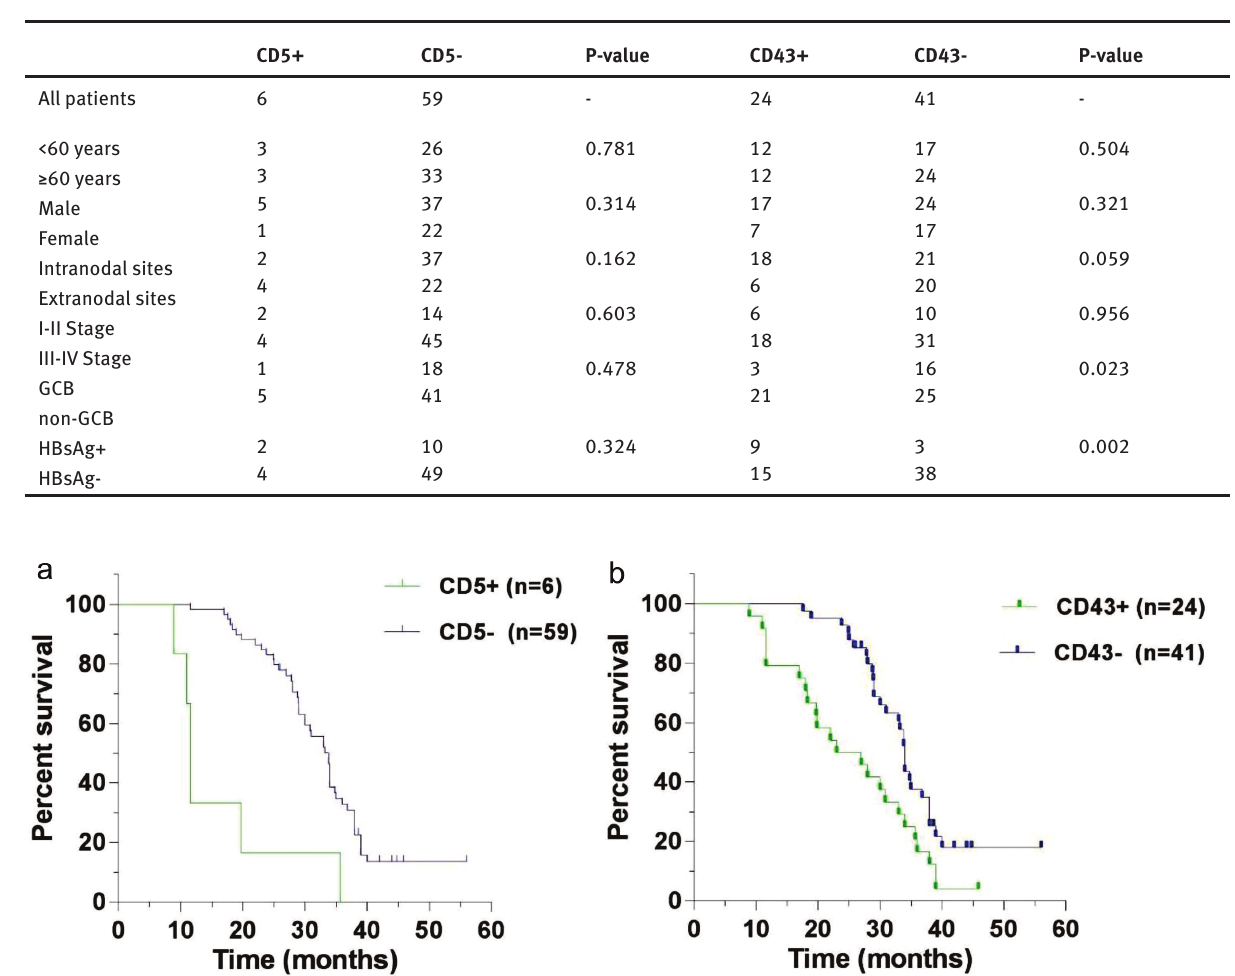
Table 3: The relationship between CD5 and CD43 expression and clinicopathological features (n =